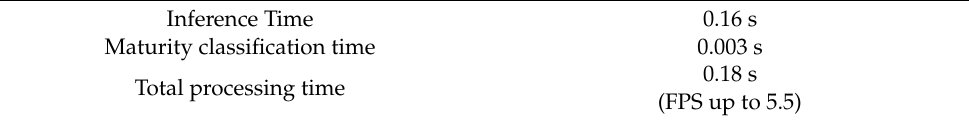
Table 3. Processing speed of monitoring with the NVIDIA GTX 2080 ti